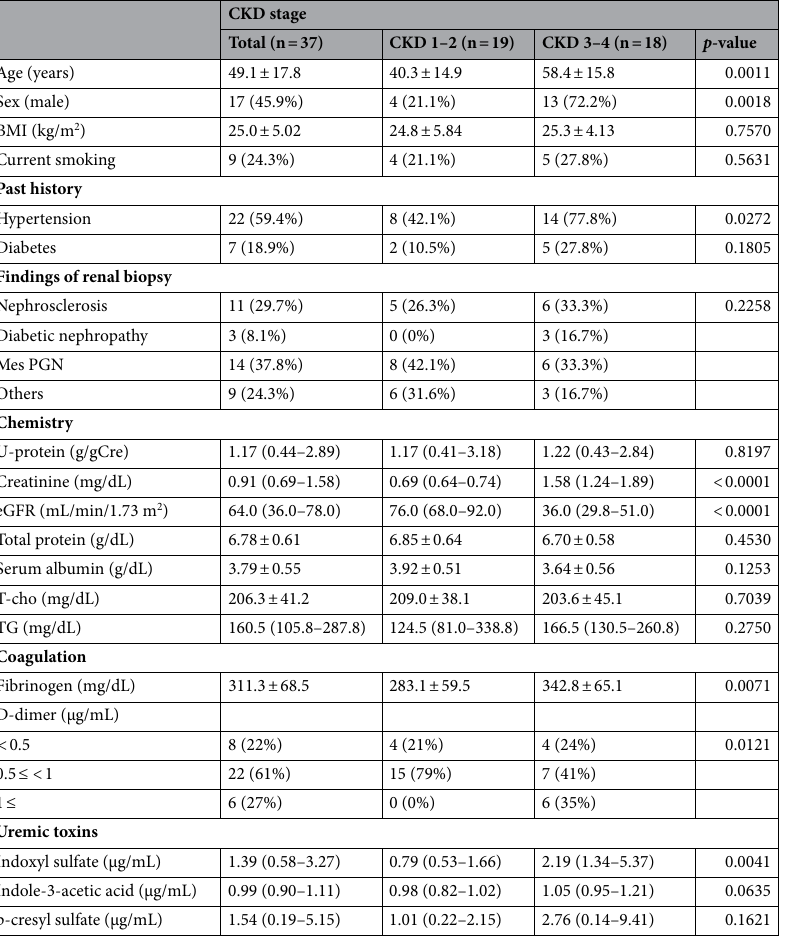
Table 1. Basal characteristics of the renal biopsy cohort. CKD, chronic kidney disease; BMI, body mass index; Mes PGN, mesangial proliferative glomerulonephritis; U-protein, urinary protein; gCre, g creatinine; Cre, creatinine; eGFR, estimated glomerular filtration rate; T-cho, total cholesterol; TG, triglyceride. There is one missing data point in the plasma fibrinogen and D-dimer data. The data are shown as the mean ± SD or as the median with interquartile